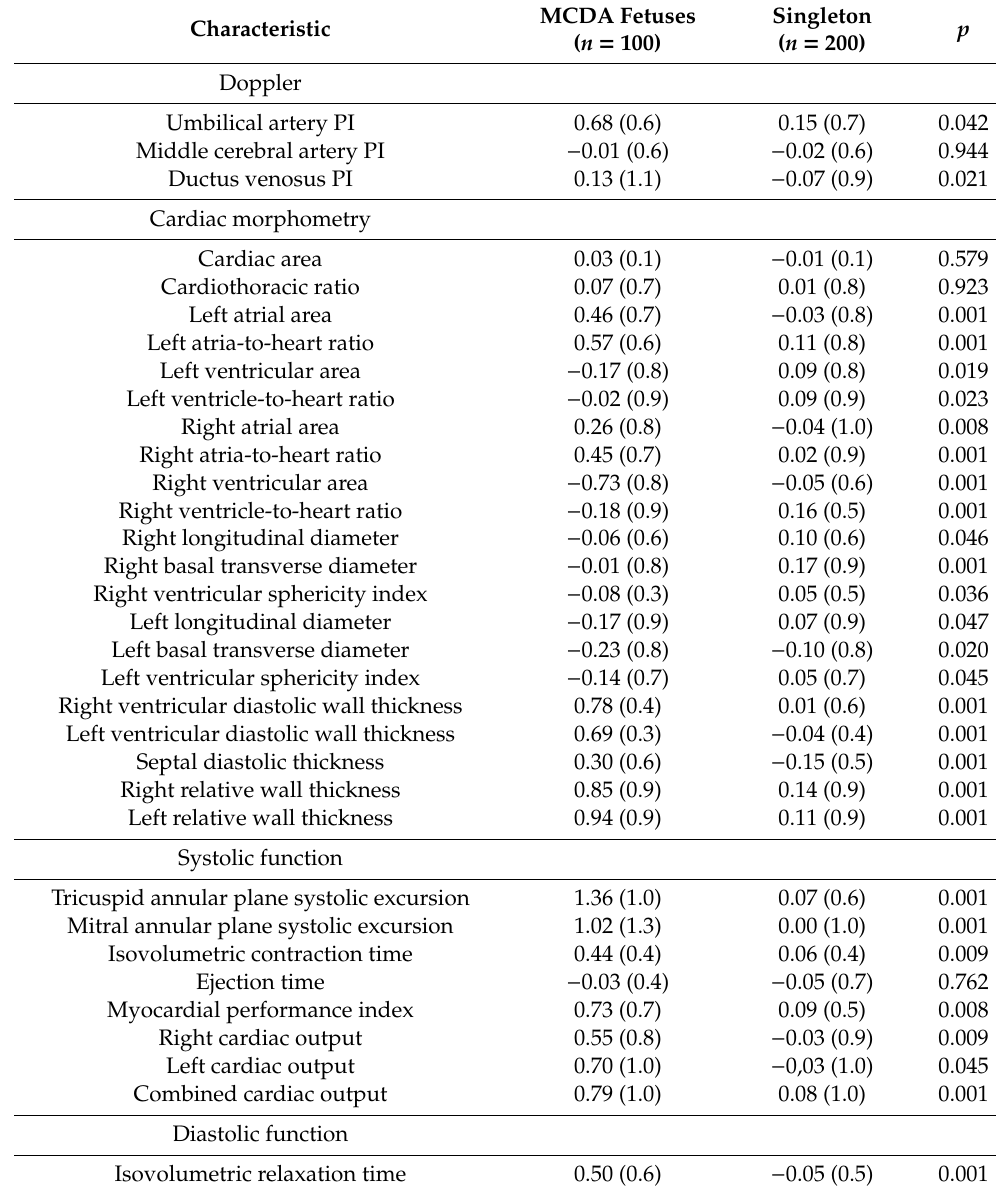
Table 3. Doppler, cardiac morphometric, and functional parameter z-scores of 100 monochorionic diamniotic twin fetuses and 200 low-risk